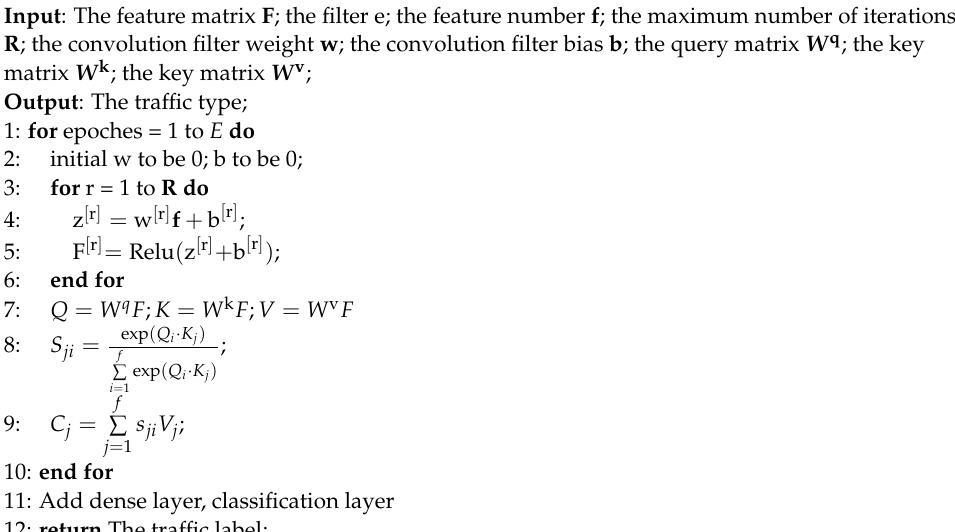
Algorithm 2 CNAT precoder Algorithm.